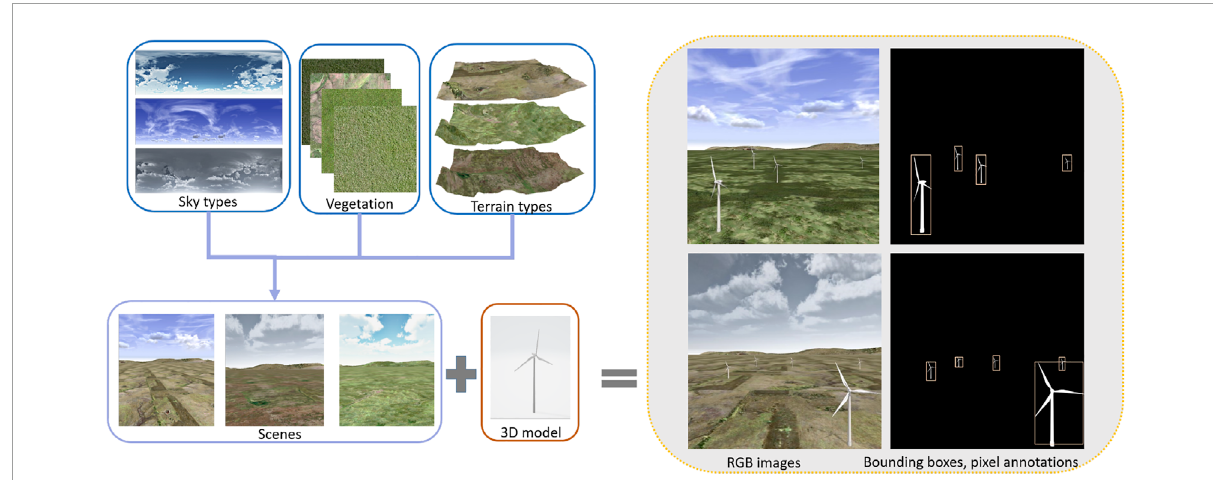
FIGURE 2 The process of generating synthetic wind turbine datasets. The three blue boxes in the upper left are the basic materials to simulate real scenes of wind farms. Randomly place the public available 3D wind turbine models in the synthetic wind farms, and set height and moving step of the virtual camera, synthetic RGB images are captured. For pixel annotations, ignore the environment scene, then repeat the steps for capturing RGB